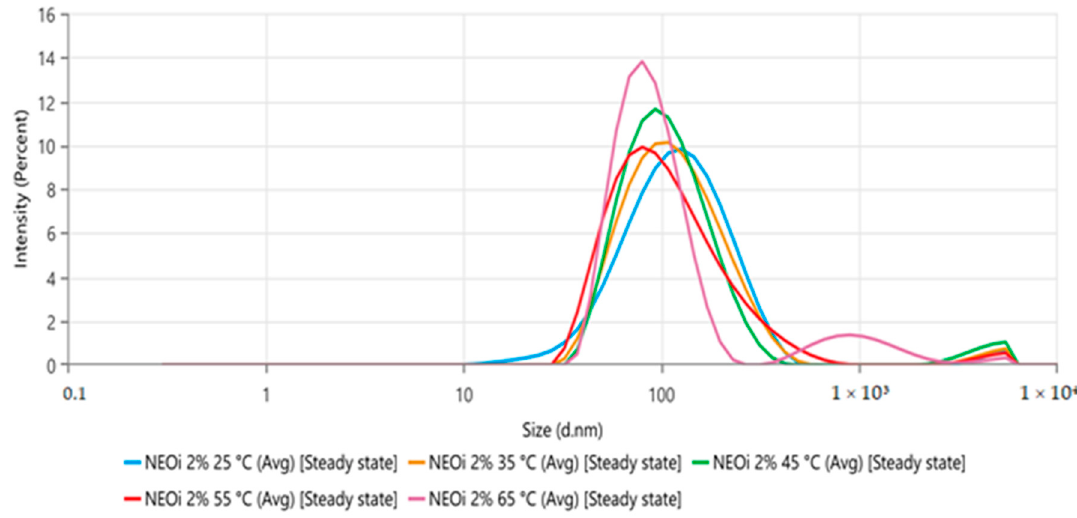
Figure 2. NE thermal stress (25–65 °C) size distribution by intensity. Table 2. NE mean size and PdI values from the thermal stress stability study (25–65 °C). Temperature ( ◦